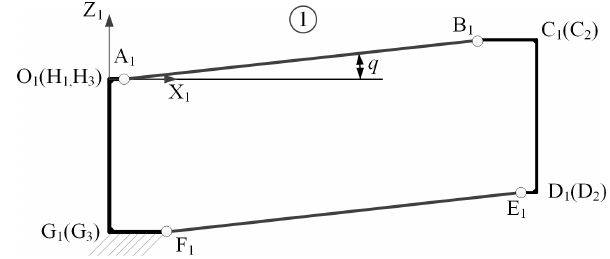
Figure 11. Planar rib mechanism (cid:192) .